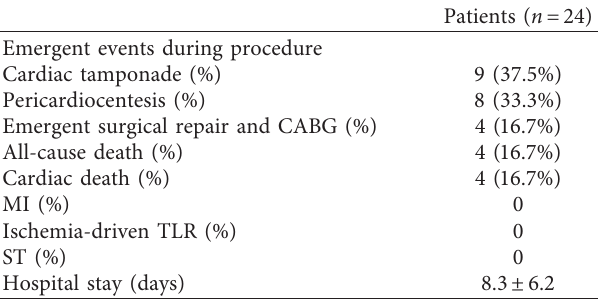
Data are shown as absolute numbers and percentage (%) or mean- ± standard deviation. CABG: coronary artery bypass grafting; MI: myo- cardial infarction; TLR: target lesion revascularization; ST: stent